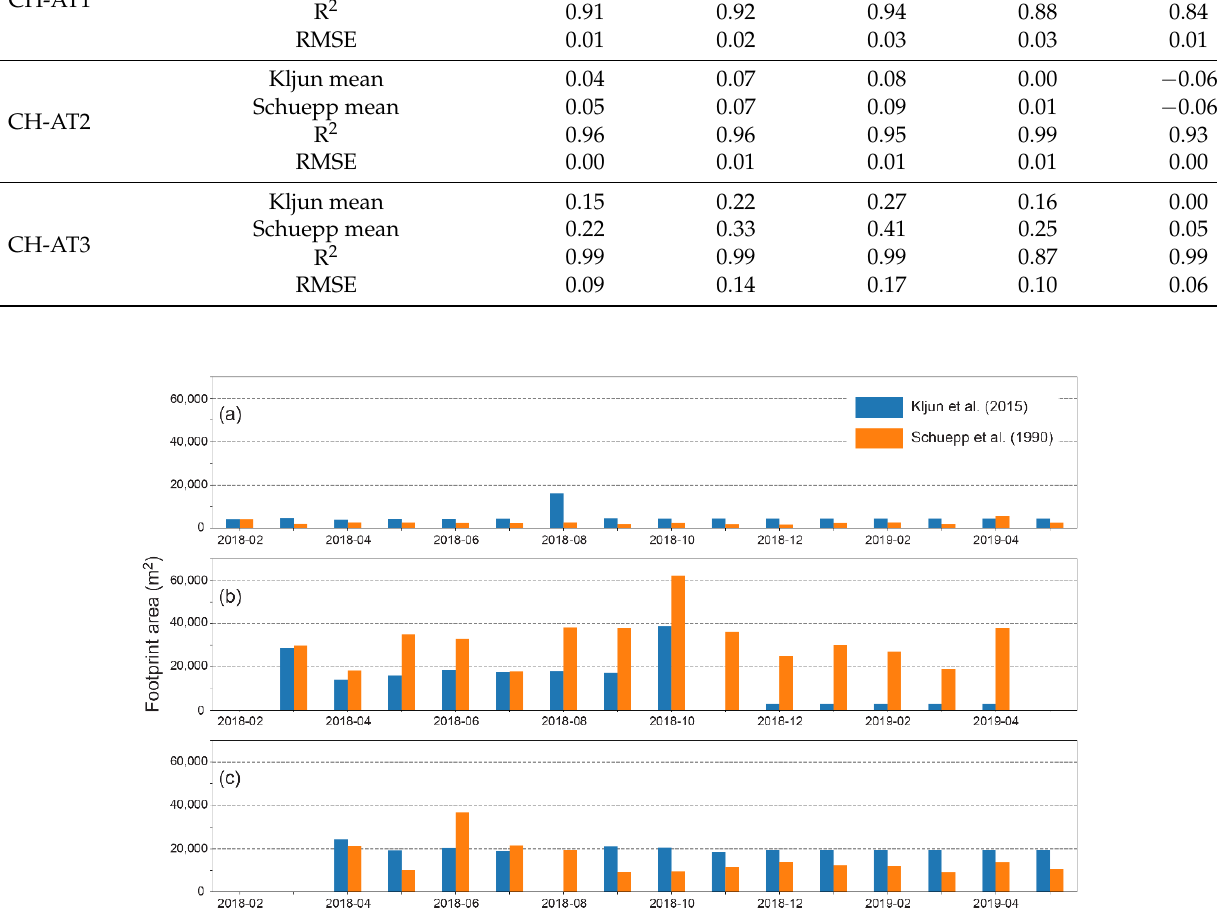
Figure 4. Footprint areas calculated with the Kljun et al. [57] approach and the Schuepp et al. [55] approach at a monthly level for the ( a ) CH-AT1, ( b ) CH-AT2, and ( c ) CH-AT3 sites.